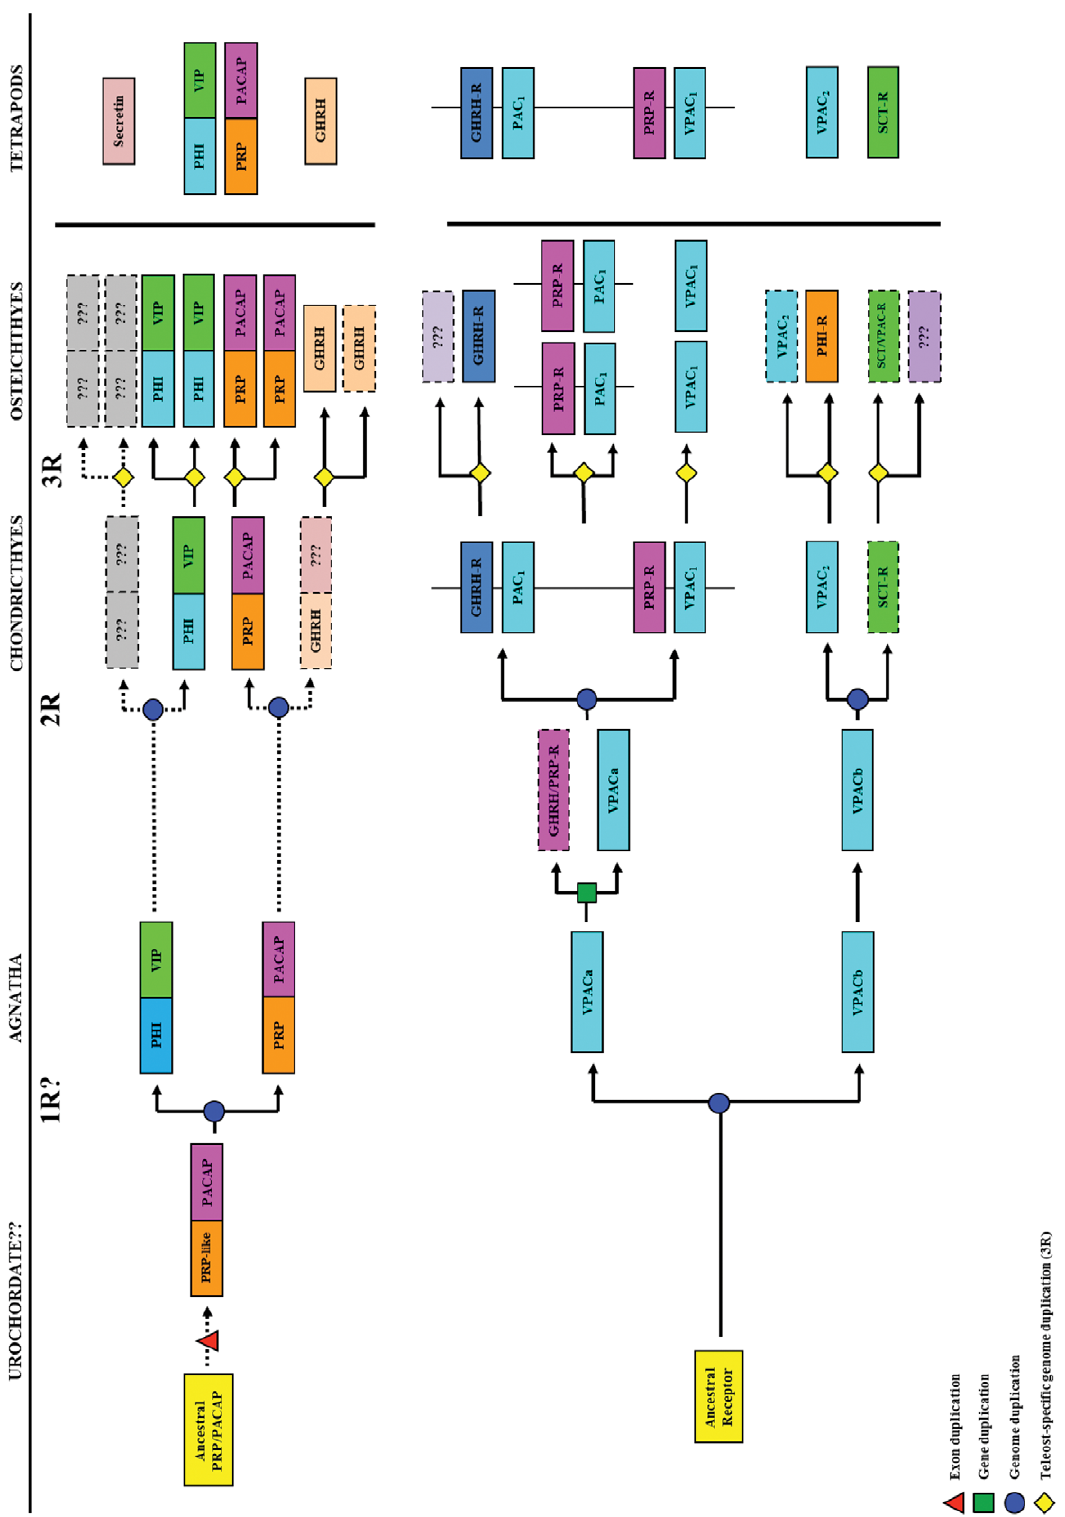
Figure 7. An evolutionary scheme of the VIP/PACAP ligands and receptors in vertebrates. The boxes denote exons for the ligands and genes for the receptors. Unknown or unclear events are denoted by dotted lines or question marks. The phylogenetic timeline for the events are not to scale.